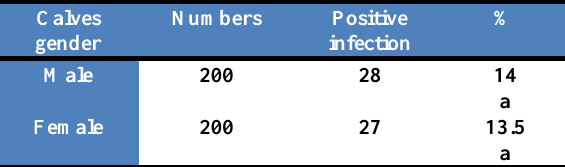
Table, 5: Relationship between gender and rotaviral infection in examined calves.